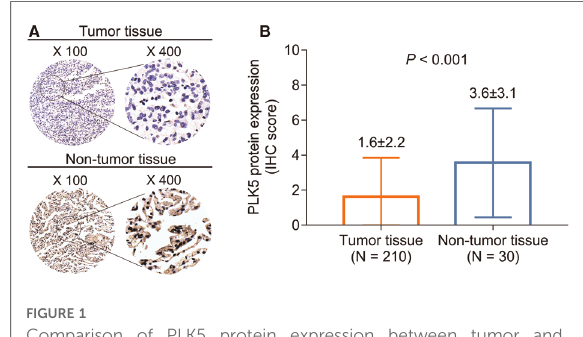
FIGURE 1 Comparison of PLK5 protein expression between tumor and nontumor tissues in NSCLC patients. PLK5 protein samples in tumor and nontumor tissues ( A ); PLK5 protein expression was reduced in tumor tissue in contrast with nontumor tissue in NSCLC patients ( B ).